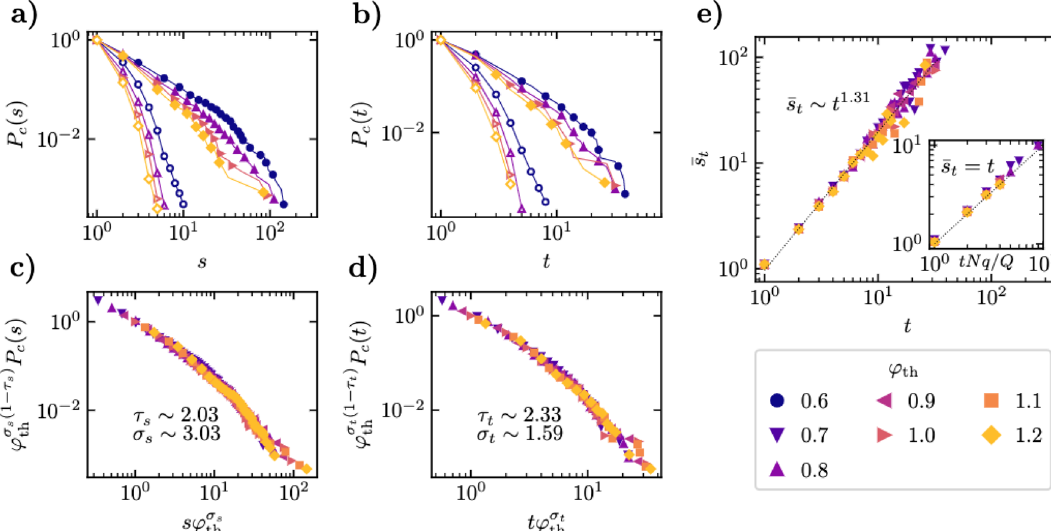
Figure 2. ( a ) Cumulative probability distribution of the avalanche sizes P c ( s ) for different values of the turning threshold ϕ th . ( b ) Cumulative probability distribution of the avalanche durations P c ( t ) for different values of the turning threshold ϕ th . In ( a ) and ( b ), filled symbols represent the actual empirical distributions, while hollow symbols correspond to distributions obtained by randomizing the turning angles in the trajectory of each fish. ( c ) Check of the scaling of the cumulative size distribution with the turning threshold, as given by Eq. (5). ( d ) Check of the scaling of the cumulated time distribution with the turning threshold, as given by Eq. (5). ( e ) Average size ¯ s t of avalanches of fixed duration t as a function of t . The main plot shows the empirical data. The inset presents the results from a randomization of the turning angles in each fish trajectory. In this case, we plot the average duration as a function of the theoretical prediction Nqt / Q , see Eq.